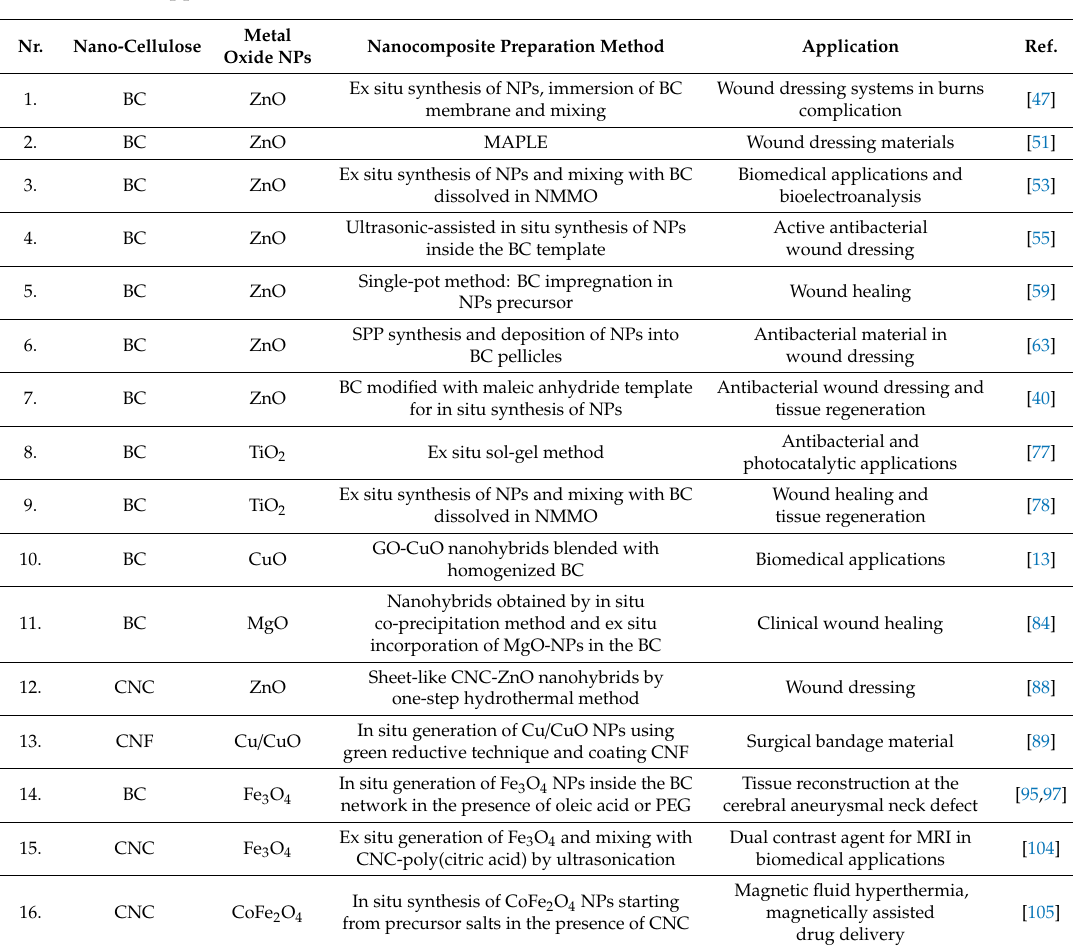
Table 1. Various types of metal oxides incorporated in nanocellulose to obtain functional hybrids for biomedical